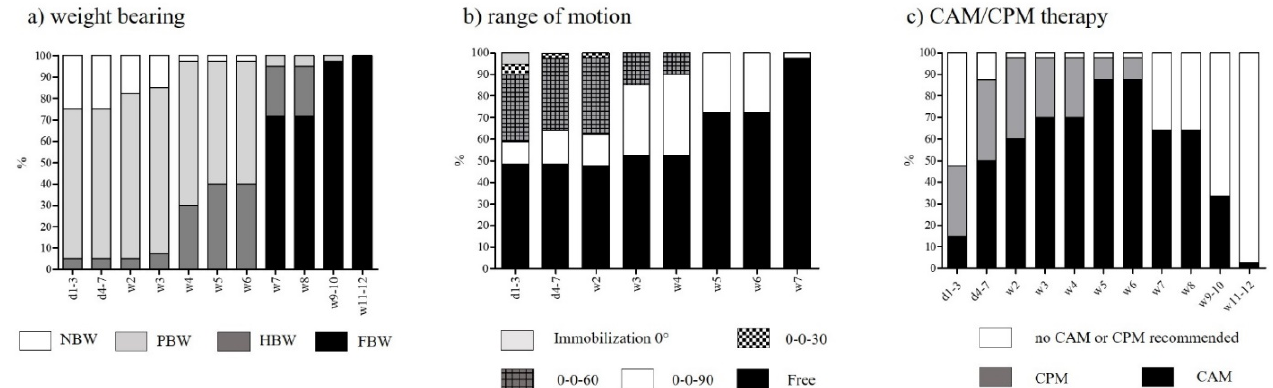
Figure 4. Early rehabilitation phase after femorotibial MACT concerning ( a ) weight-bearing, ( b ) range of motion, and ( c ) motion therapy, expressed as the percentage of protocols. NBW: no body weight; PBW: partial body weight; HBW: half body weight; FBW: full body weight; CAM: continuous active motion; CPM: continuous passive motion; d: day; w: week.